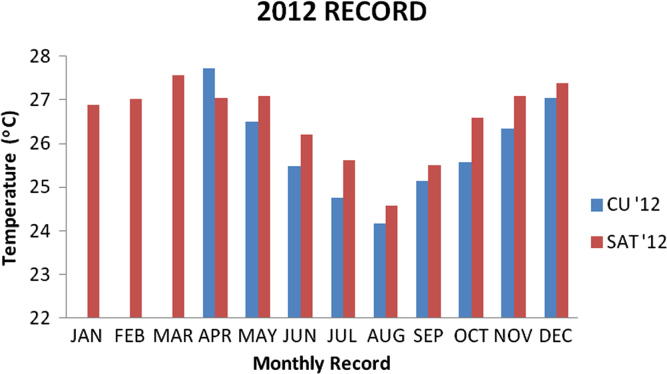
Chart for 2012 data.